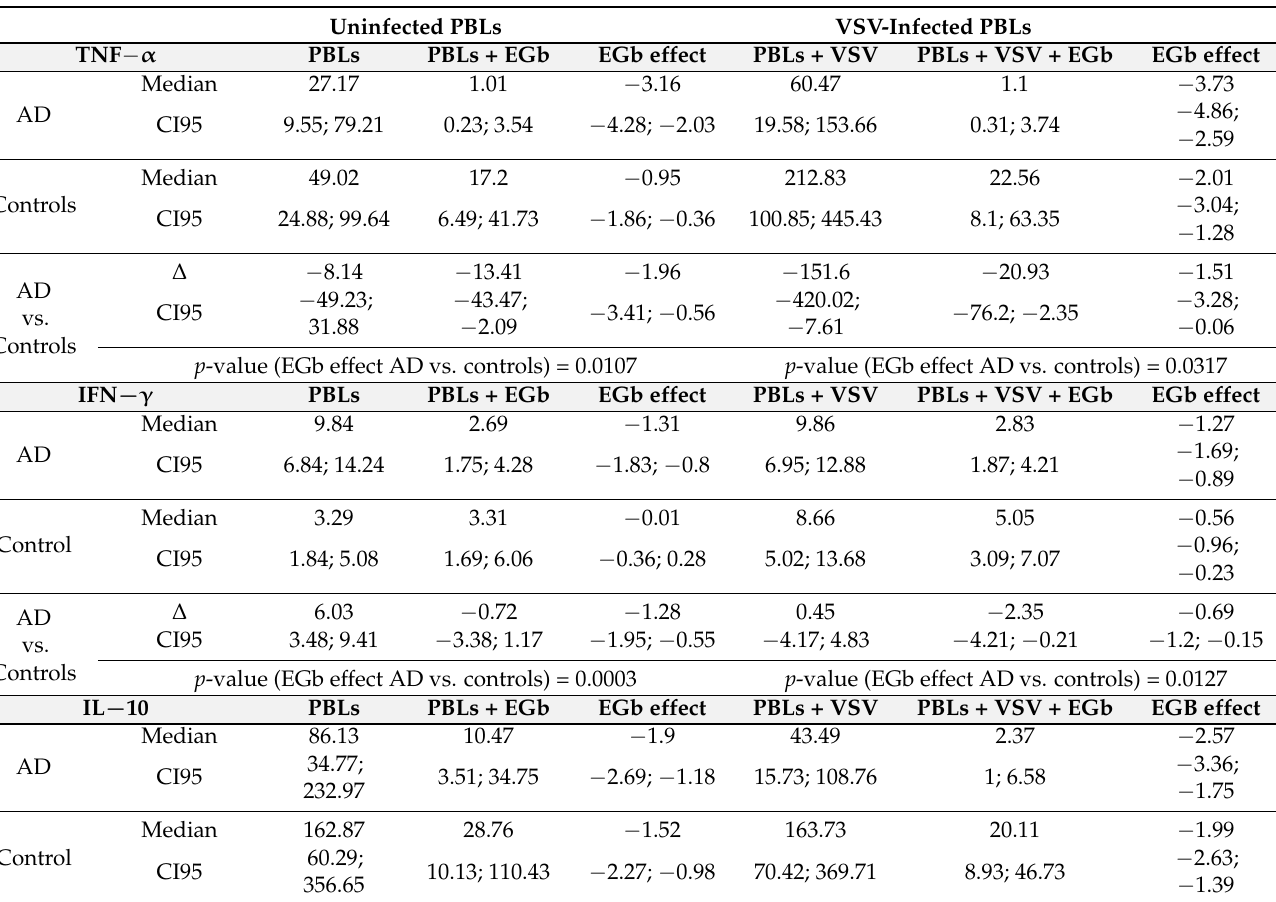
Table 5. Uninfected (spontaneous) and VSV-infected cytokine production by PBLs. Effect of EGb treatment. Median is measure of average level. For every individual person and for every change = log ( after ) − log ( before ) . EGb effect in cytokine level after EGb, treatment equals d = log after before is average of all d (cid:48) s in a group. EGb effect is than average of ratios after expressed in logs. Delta before ∆ is measure of difference in EGb effects between AD and controls, and this statistic is the average difference between a randomly selected person from AD group and a randomly selected person from control group. Uninfected